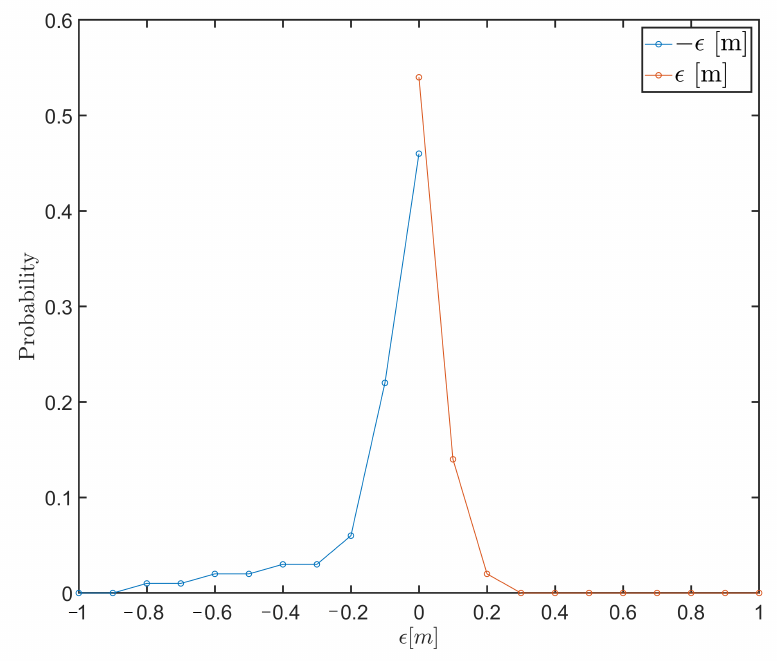
Figure 17. Estimated probability at 95% confidence level using a range of upper and lower deci- sion